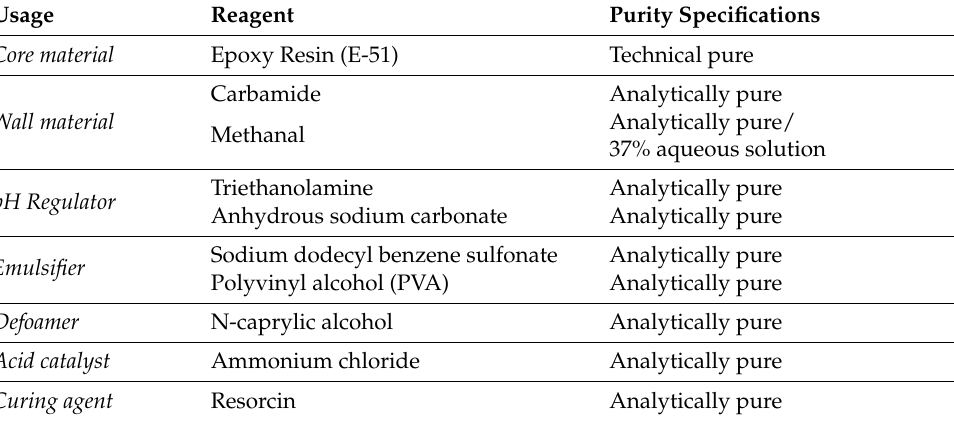
Table 3. Synthesis materials of microcapsule.